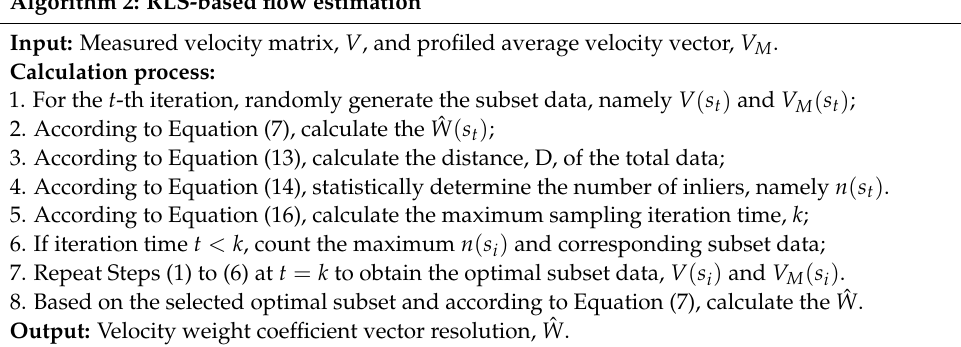
Algorithm 2: RLS-based flow